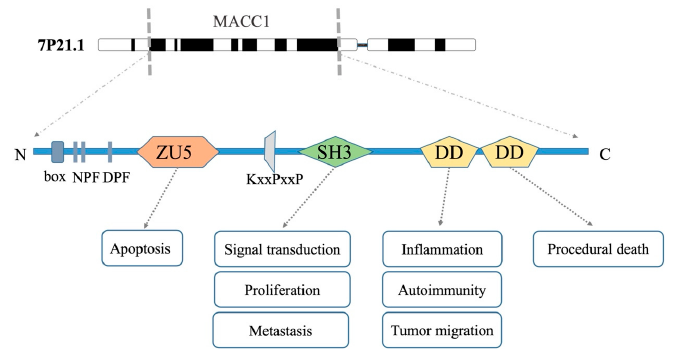
Figure 1. MACC1 domain and potential function. Interaction motifs for clathrin-mediated endocytosis (clathrin box, NPF, DPF); the functions of the ZU5 domain at MACC1 N-terminus are mainly associated with apoptosis; proline-rich motifs (KxxPxP) and SH3 (Src homology domain) domains play a part in interactions between proteins; there are two death domain family (DD) domains at MACC1